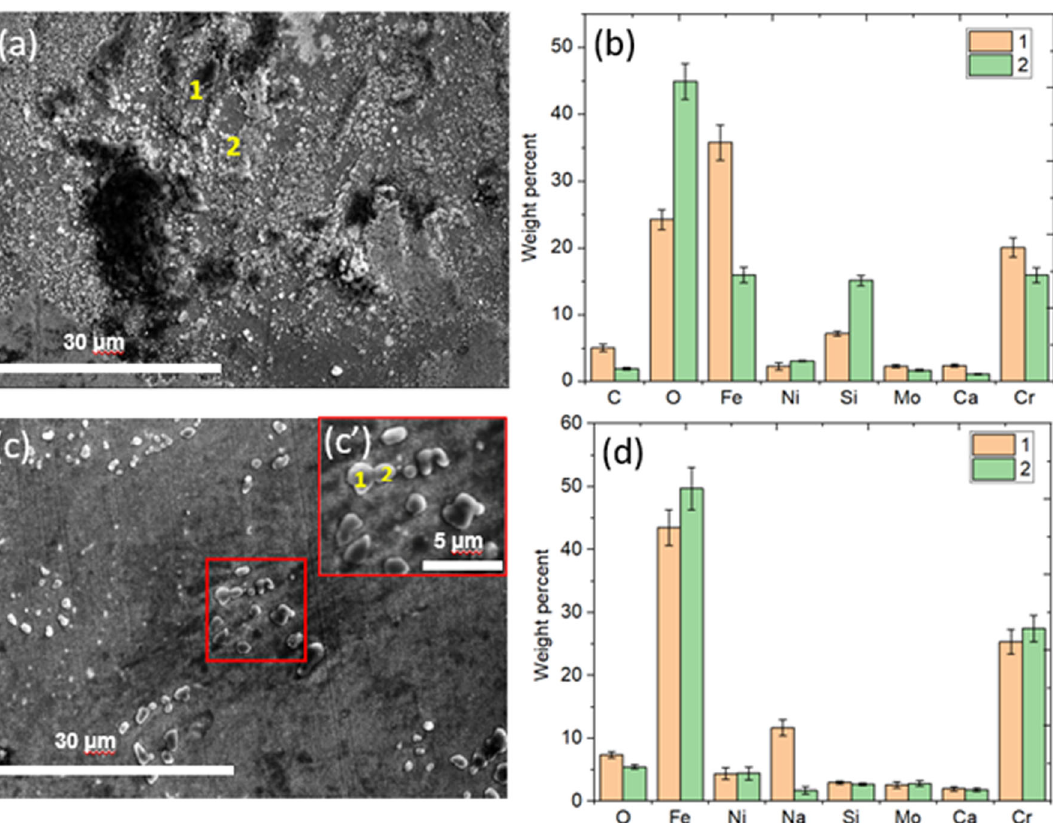
Fig. 3 Morphology of secondary phase precipitation on SS( + ISG). a Secondary phase precipitation on SS( + ISG) for 0.6 M NaCl outside the crevice mouth. b Chemical composition of precipitates determined at points 1 and 2 in ( a ). c Secondary phase precipitation on SS( + ISG) for silica-saturated NaCl outside the crevice mouth. d Chemical composition of precipitates determined at 2 regions (1 and 2 in inset c ’ ) by EDS.